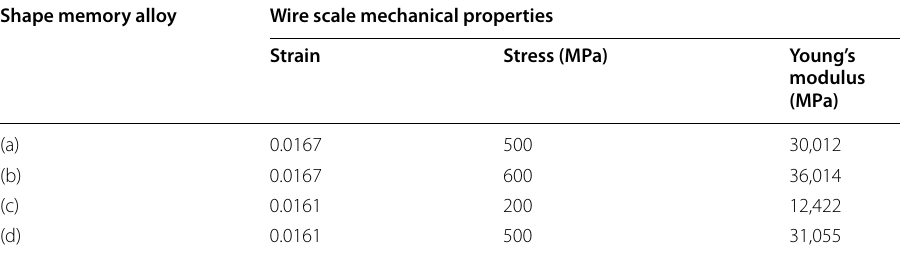
Table 2 Wire scale mechanical properties of shape memory alloy wires 0.3 mm, 22 ℃ (a), 0.3